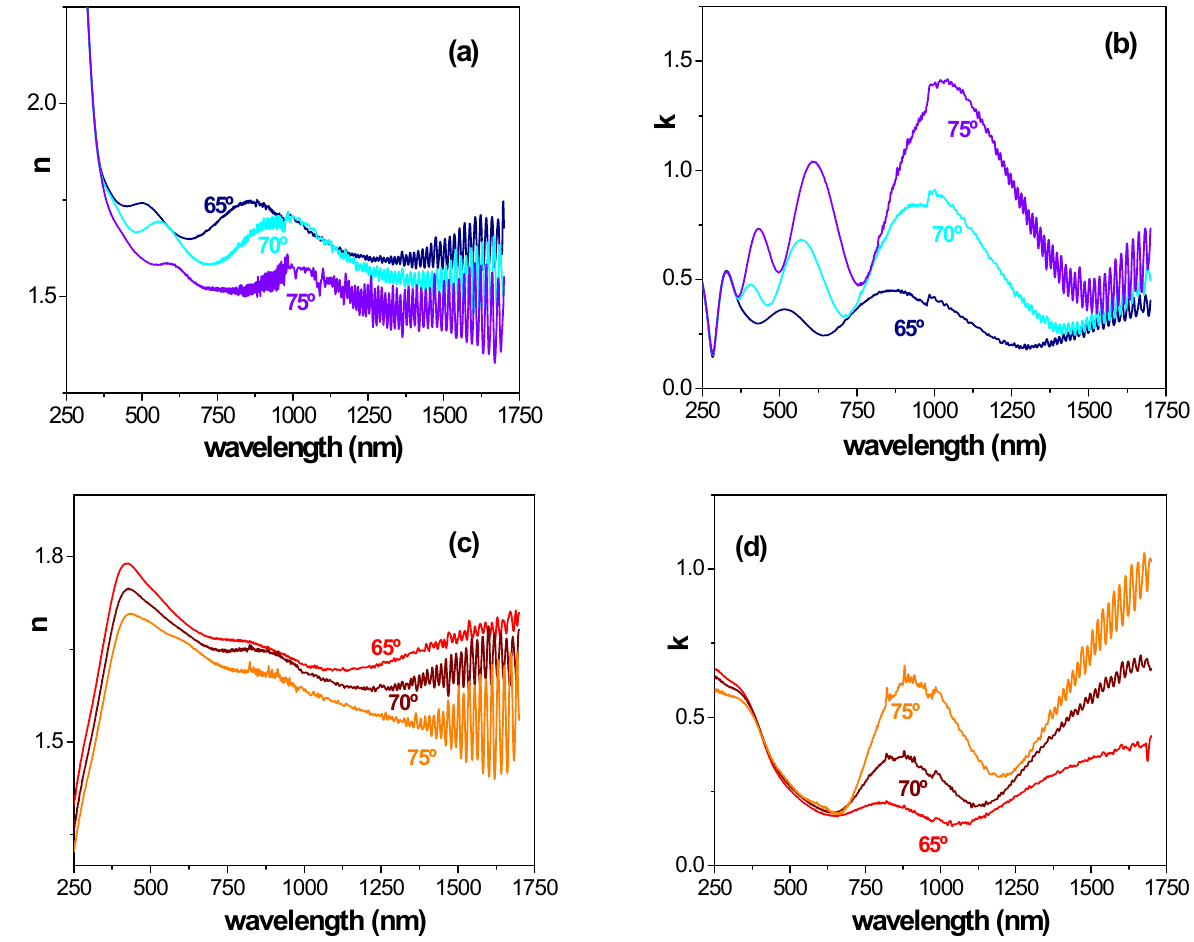
1.67; <n(Ox(A)/Fe 2 O 3 )> = 1.66; <k(Ox(A)/SiO 2 )> = 0.47; <k(Ox(A)/TiO 2 )> = 0.33; and